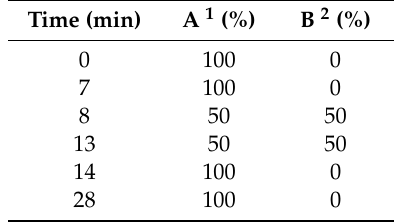
Table 3. HPLC elution program of the binary gradient system for NAC